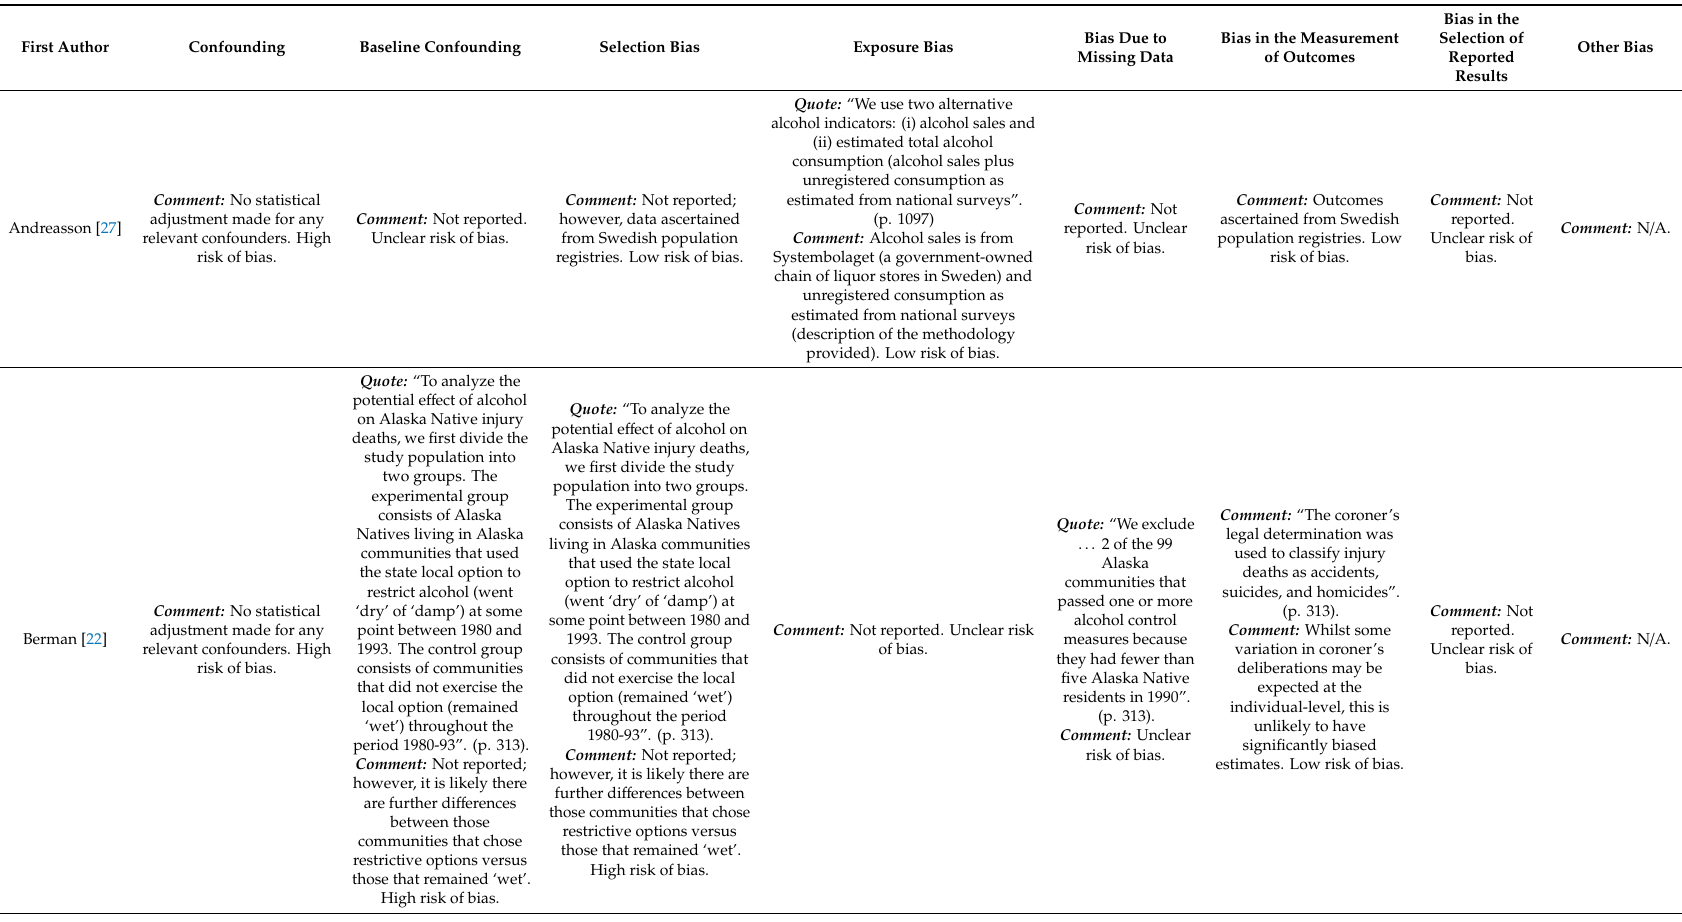
Table A1. Risk of bias